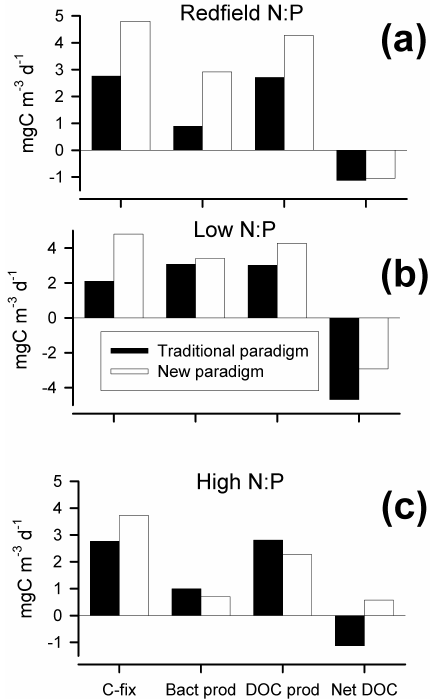
Fig. 5. Model output showing rates of primary production (C- fix), bacterial production (Bact prod), production of DOC (from all sources, including voiding of material by grazers and primary pro- duction leakage, DOC prod), and net DOC (i.e. biological produc- tion of DOC – bacterial uptake of DOC; a negative value indicates that bacteria are reliant on DOC in part from outside of the mixed layer). In the traditional paradigm, the flagellates capable of pho- totrophy (ANFs) have no mixotrophic potential, while in the new paradigm, they (MNFs) exhibit mixotrophy (see also Figs. 2, 3 and 4). The inorganic nutrient regimes (all with an inorganic N input of 1µM) are in Redfield N:P (molar ratio 16; A), low N:P (molar ratio 4; B), or high N:P (molar ratio 64;